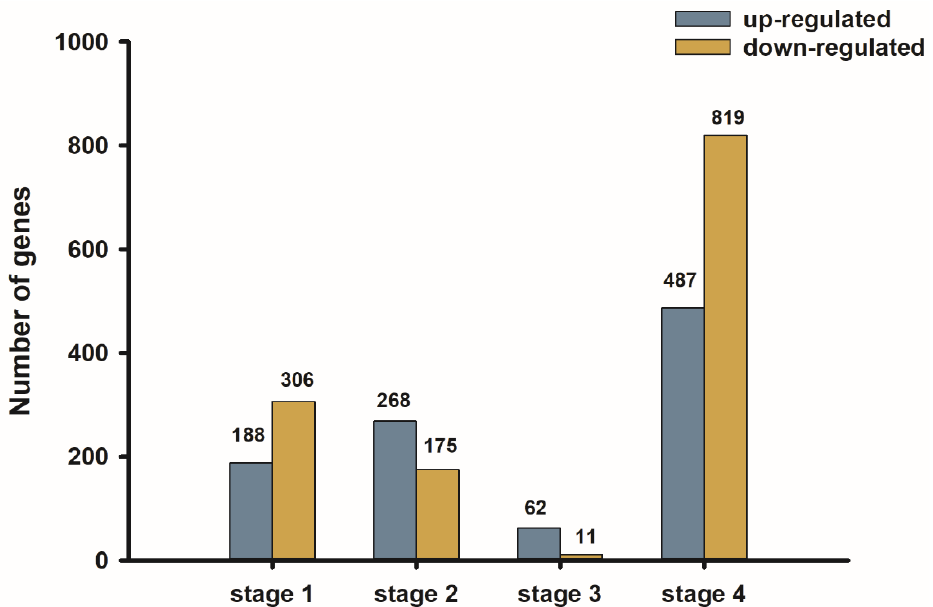
Figure 4. The number of differentially expressed genes in four development stages.